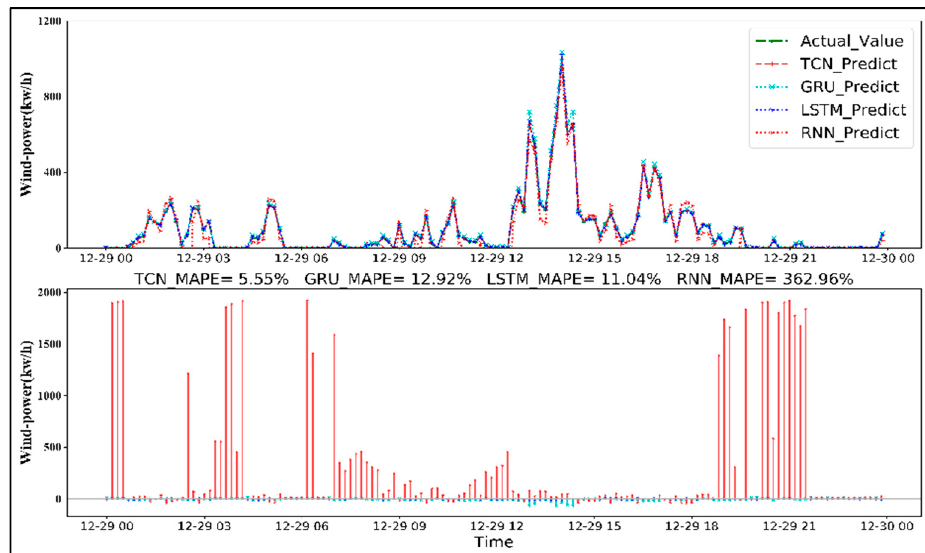
Figure 11. 72-h wind power prediction (Experiment I).